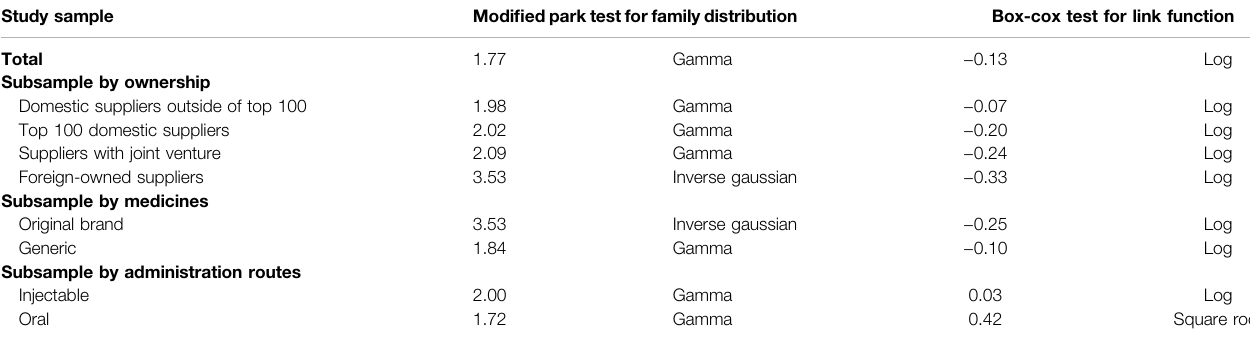
TABLE 2 | Estimation of link function (Park tests) and family distribution (Box – Cox tests) of unit price of pharmaceutical